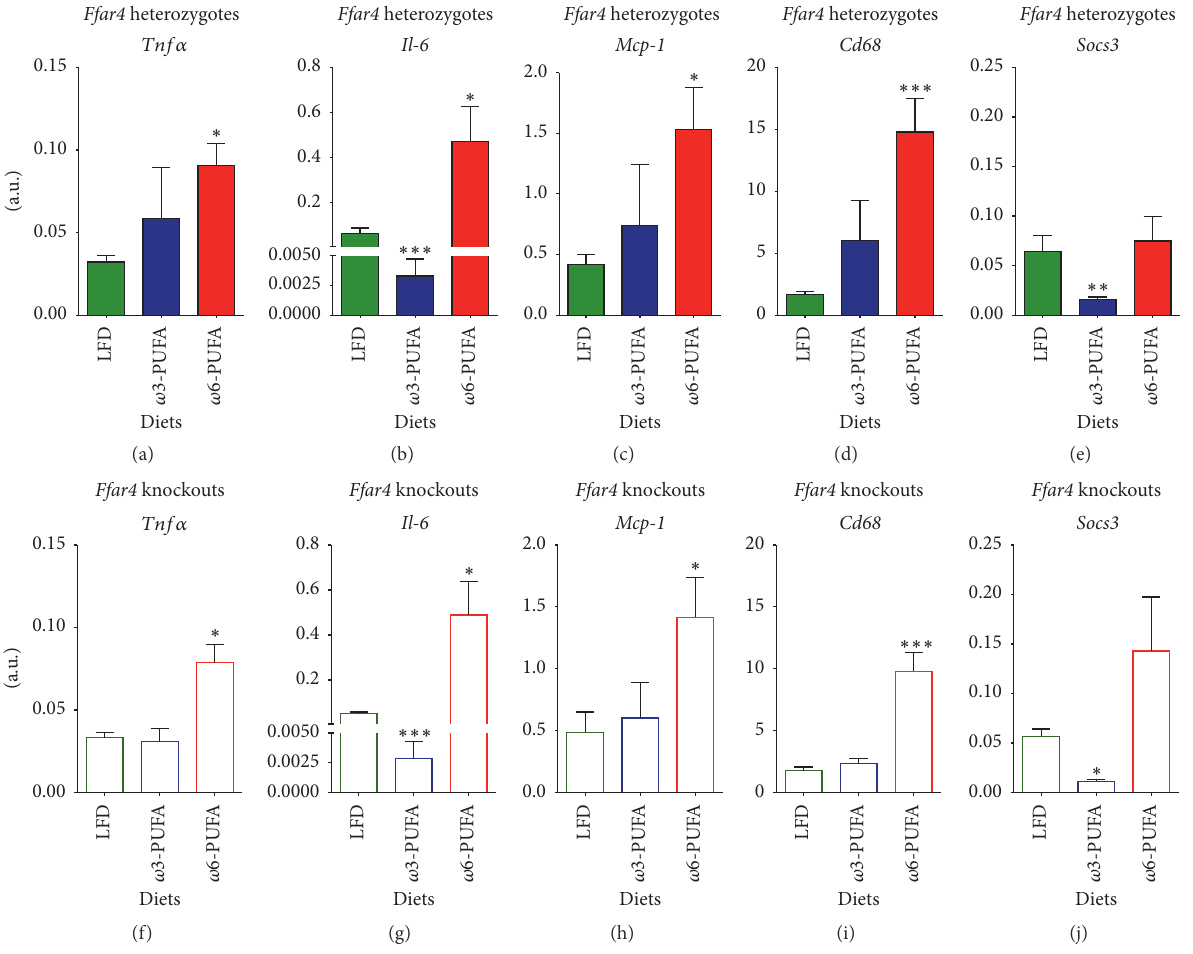
Figure 5: Inflammatory status of eWAT is indistinguishable between Ffar4 HET and KO mice. Mice were euthanized in nonfasting state 36 weeks after diet initiation. Gene expression levels were analyzed by RT-qPCR. ((a)–(e)) Heterozygotes. ((f)–(j)) Knockouts. ((a) and (f)) mRNA level of Tnf 𝛼 , 𝑛 = 4 –8. ((b) and (g)) mRNA level of Il-6 , 𝑛 = 4 –8. ((c) and (h)) mRNA level of Mcp-1 , 𝑛 = 4 –8. ((d) and (i)) mRNA level of Cd68 , 𝑛 = 4 –8. ((e) and (j)) mRNA level of Socs3 , 𝑛 = 4 –8. Data are presented as means ± SEM. Both HFDs have been compared to the LFD. All data have been Ln-transformed and subjected to 1-way ANOVA with Bonferroni correction. ∗ 𝑝 < 0.05 , ∗∗ 𝑝 < 0.01 , and ∗∗∗ 𝑝 < 0.001